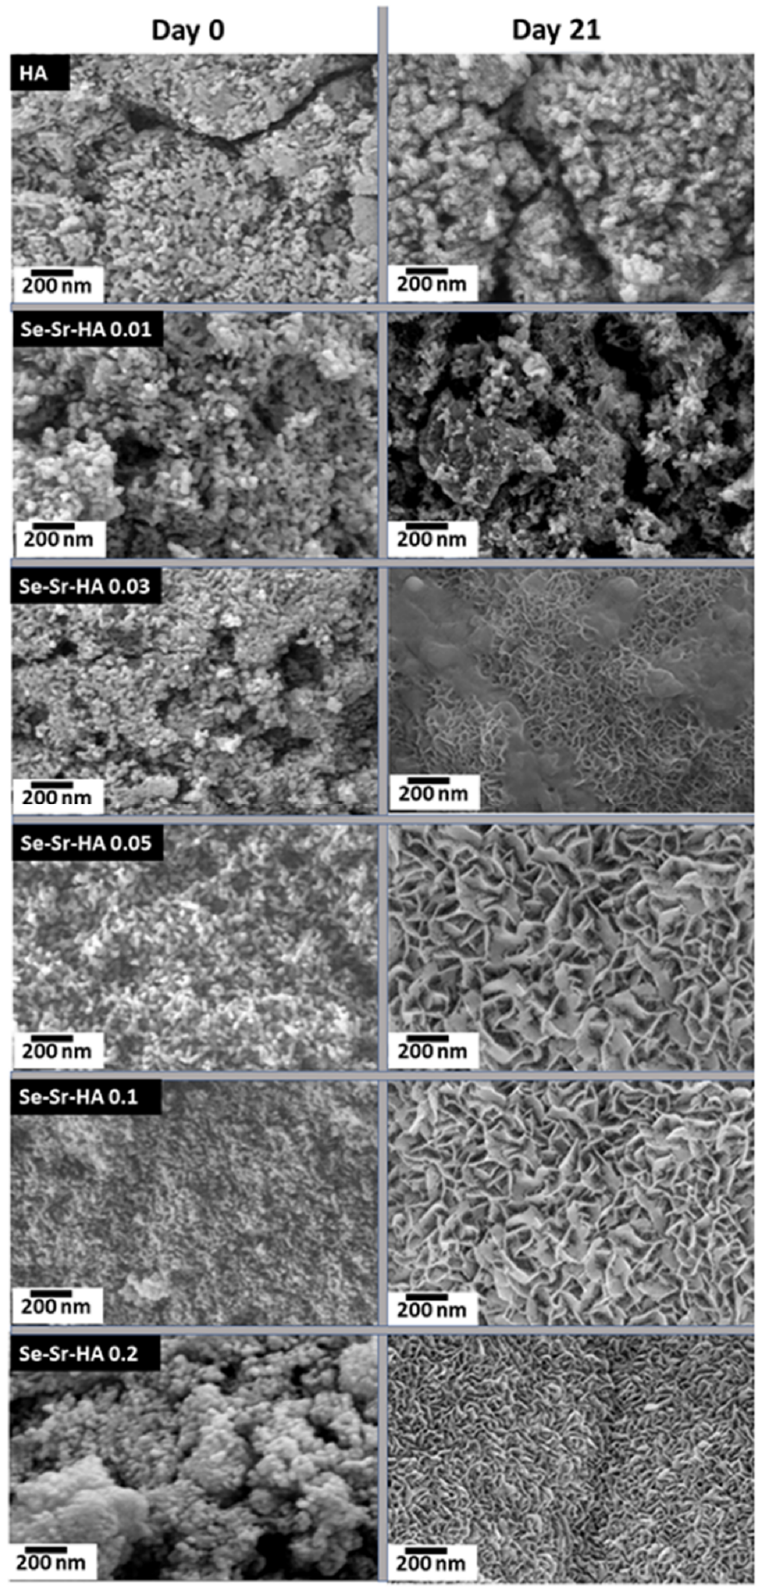
Figure 6. Selenium and strontium co-substituted HA samples before and after soaking in physiological medium (SBF) for 21 days under dynamic conditions at 37 °C.